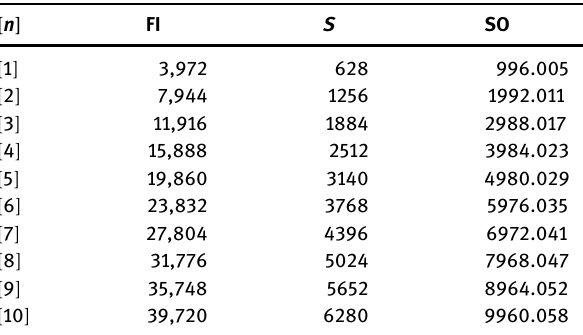
Table 7: Comparison of topological invariants by applying F - , S - , and SO - polynomials for cuboctahedral bimetallic networks ( MOPs ) at x =